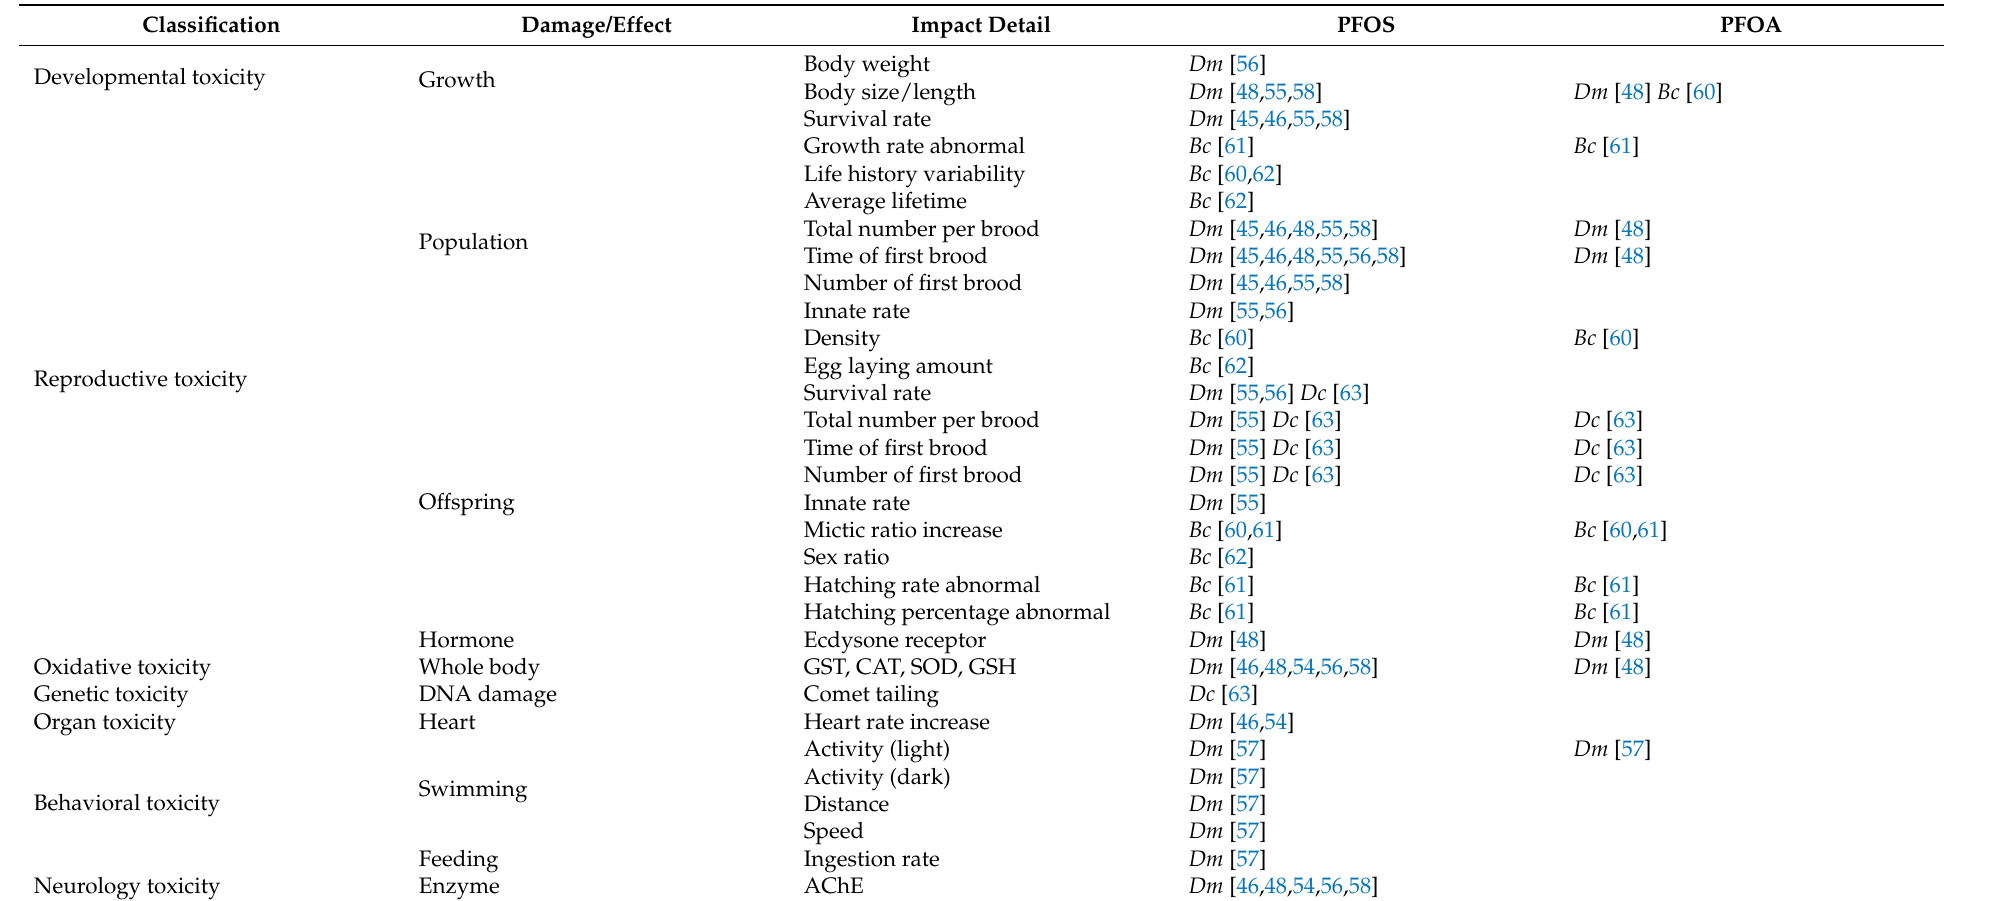
Table 3. Toxicity effects of commonly detected single PFASs on